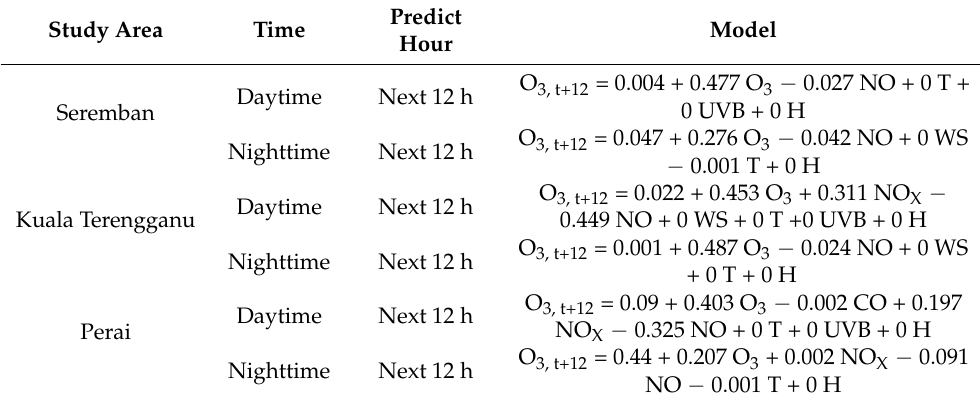
Table 5. Model summary for O 3 level predictions.